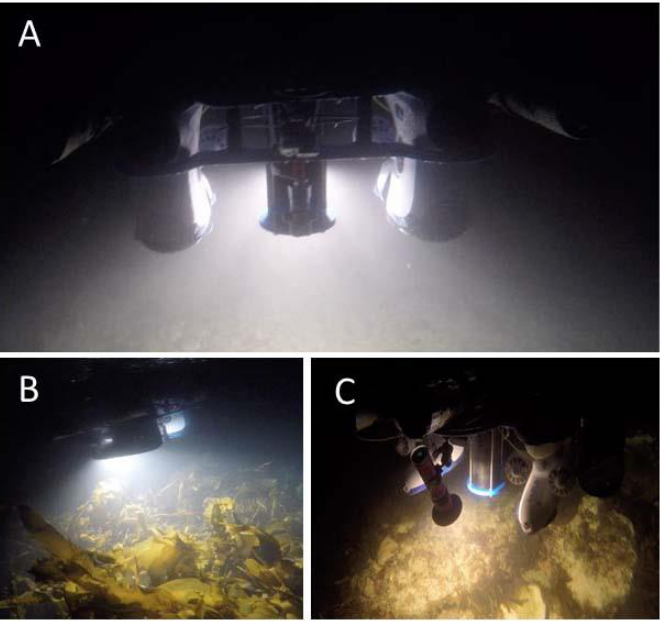
Figure 3. In situ images of mini-ROV UHI survey. ( A ) Front view of ROV-UHI rig showing illumi- nation from lamp during kelp forest mapping. ( B ) Side view of the mini-ROV-UHI over the kelp forest habitat during the transect. ( C ) Aft view of ROV with lamp and UHI over the seafloor. Credits: ( A – C ) by Geir